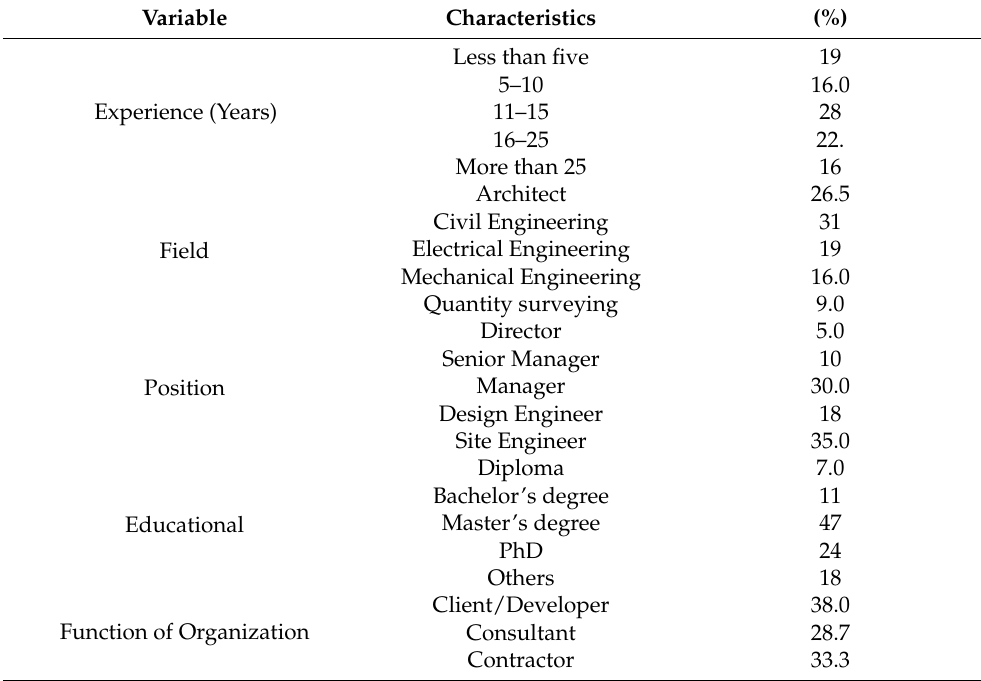
Table 2. Demographic characteristic frequency